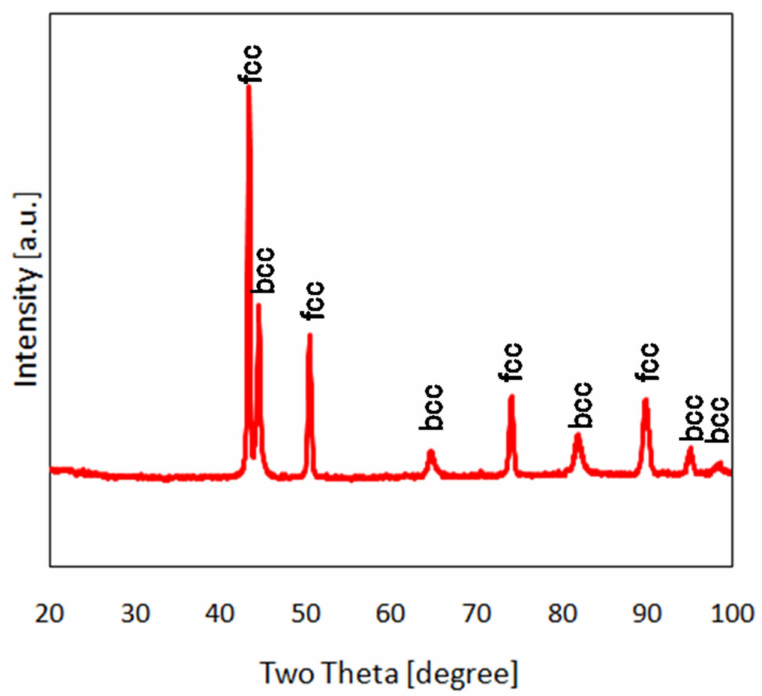
Figure 7. X-ray diffractogram for Fe–Cr–Mn–Ni